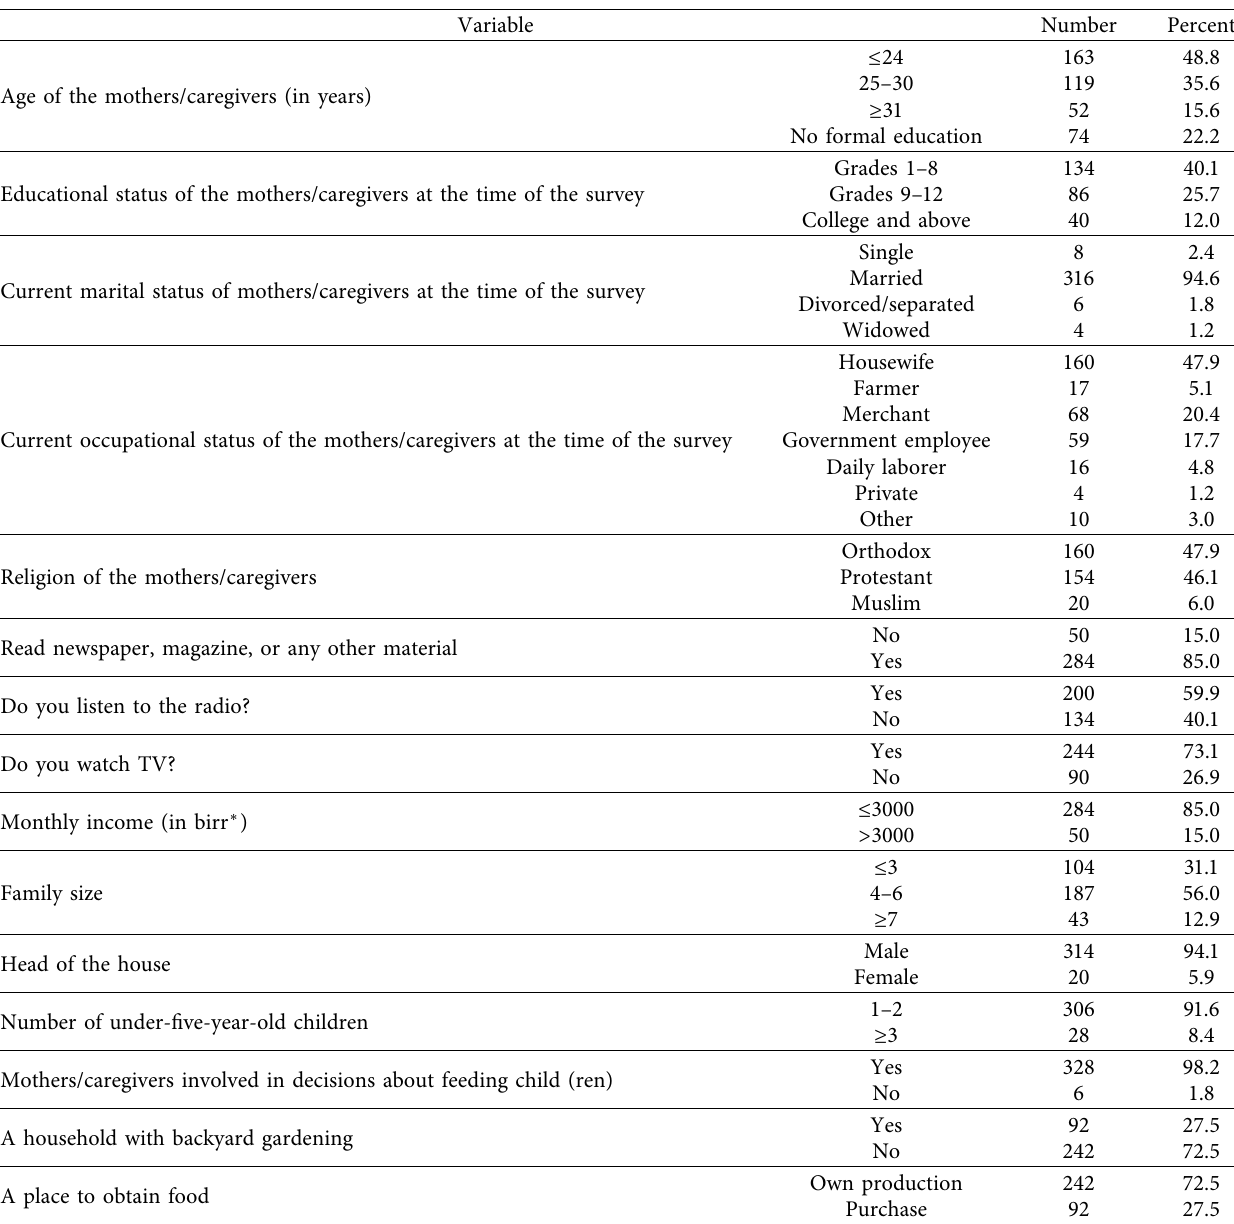
Table 1: Sociodemography and economy of mothers/caregivers and household characteristics on the study conducted to assess dietary diversity feeding practice and associated factors among 6–23-month children in Birbir Town, Ethiopia, 2018 ( n �